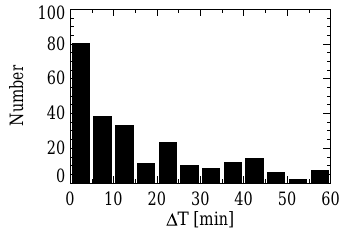
Figure 10. Histograms of the number of the adjacent events versus the time difference between two adjacent DFs for a certain adjacent event. Any two adjacent DFs are regarded as one adjacent